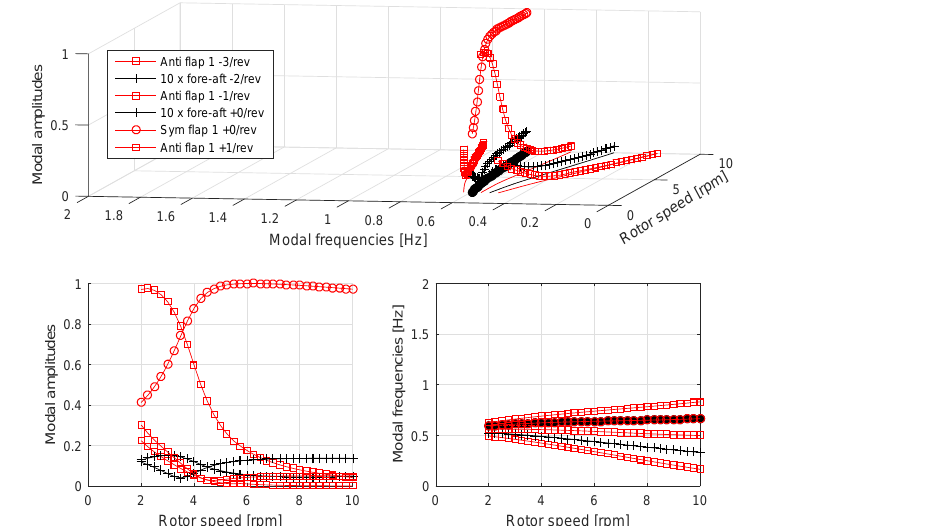
Figure 18. Harmonic modal components for the two-bladed turbine mode dominated by symmetric deflection of the rotor in the first flapwise DOF across the rotor speed range. Plot layout as in Fig. 5.